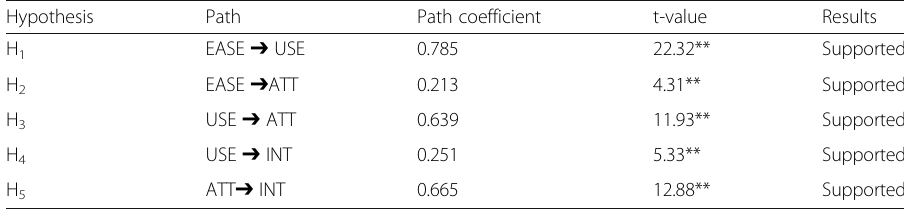
Table 5 Hypothesis testing